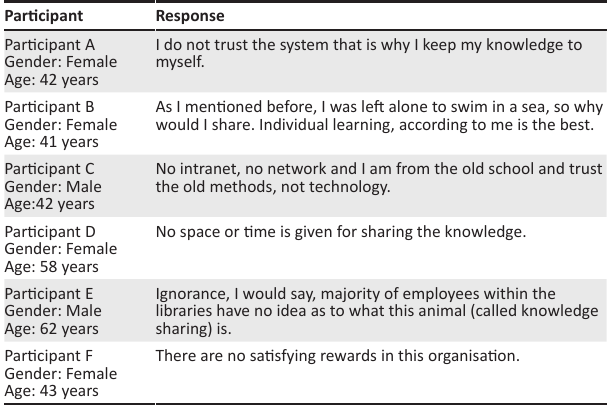
TABLE 5: Barriers to tacit knowledge sharing. Participant